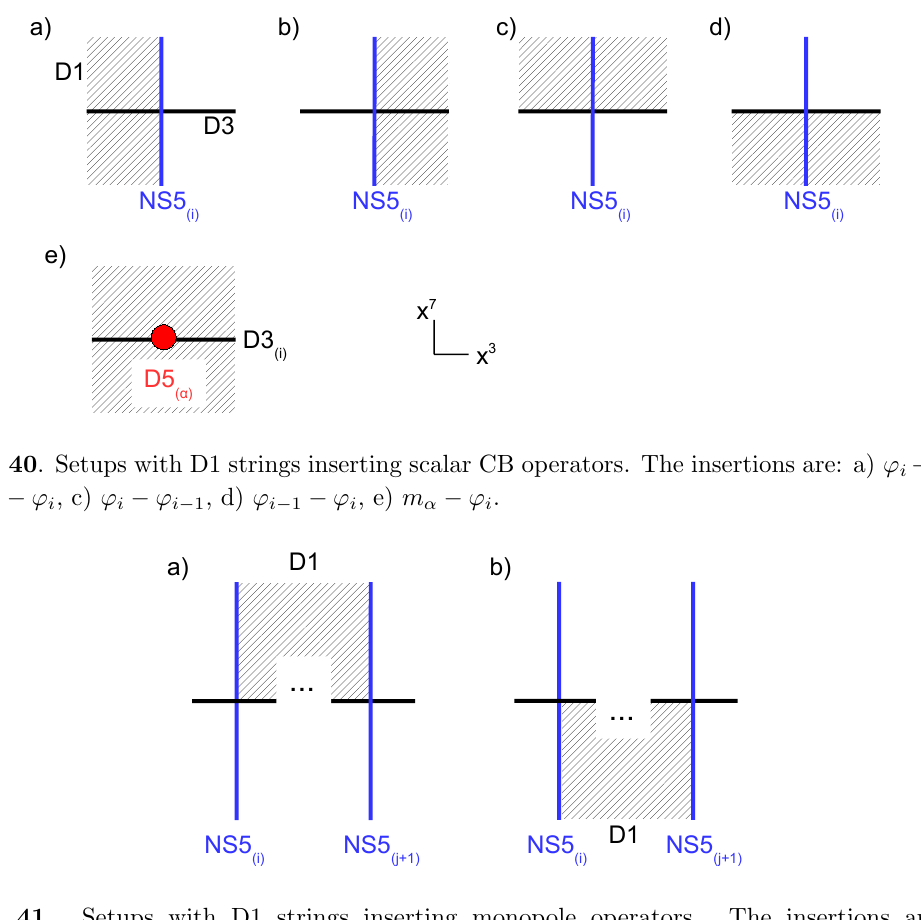
Figure 41 . Setups with D1 strings inserting monopole operators. The insertions are: a) V + , b) (cid:0) V (cid:0) . The branes which might stand in the place of the dots \ : : : " insert [ i : j ] [ i : j ]